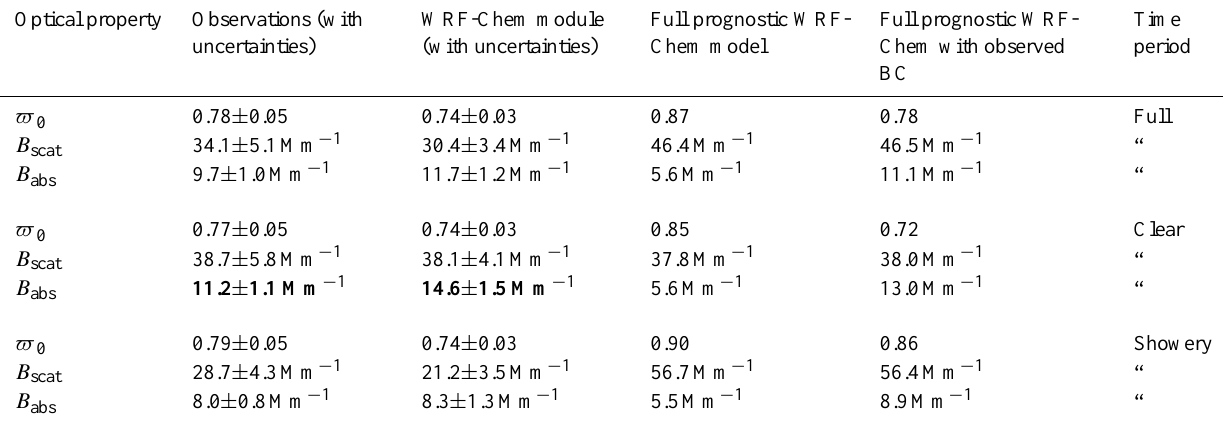
Table 2. Mean values of observed and calculated aerosol optical properties for the period 19 March through 28 March 2006. The calculated properties are shown for the module only, as well as the full, prognostic WRF-Chem model. This table also shows comparisons for the clear and showery periods. Optical properties that do not agree within estimated uncertainties are shown in boldface. The wavelength associated with all of properties listed here is 870nm.